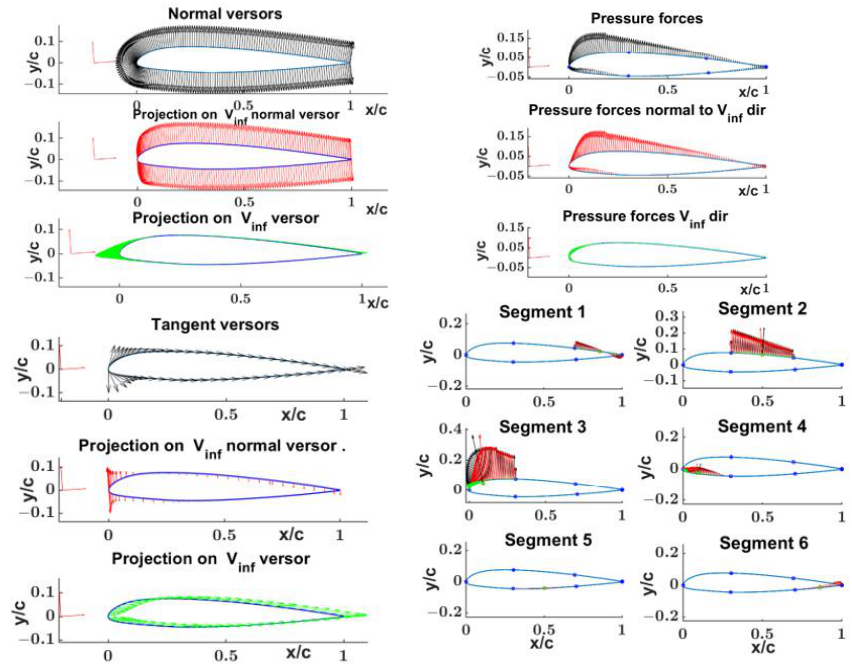
Figure 27. NACA 23012 normal & tangent vectors projection along the V inf direction, and the normal to V inf , the segments-wise contribution of pressure forces along the V inf, and the normal to it. Figure 28 shows the airfoil friction forces, their segment-wise distribution, and their projection along the V inf direction, and the normal to it.